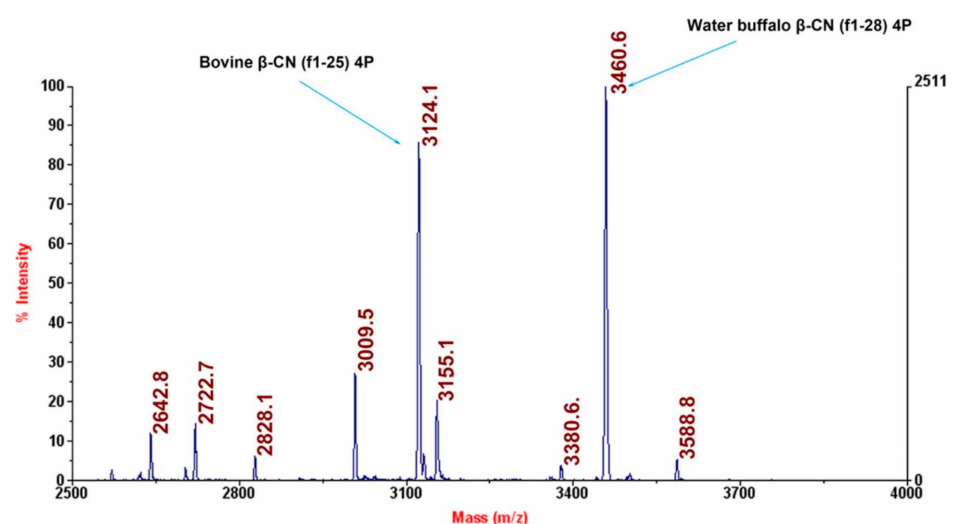
Figure 2. MALDI-TOF-MS-based identification of the proteotypic species WB β -CN (f1-28)4P and B β -CN (f1-25)4P as deriving from the CN fraction of WB milk containing 50% v/v B counterpart, which was preventively subjected to HA-based phosphoprotein enrichment and trypsinolysis. Reported is a partial view of the mass spectrum, showing well resolved ( ∆ M = +336 u), intense signals associated with the proteotypic species. WB β -CN (f1-28)4P ( theor . MH + = 3460.3); B β -CN (f1-25)4P ( theor . MH + = 3124.3). Reprinted from [16] with permission from